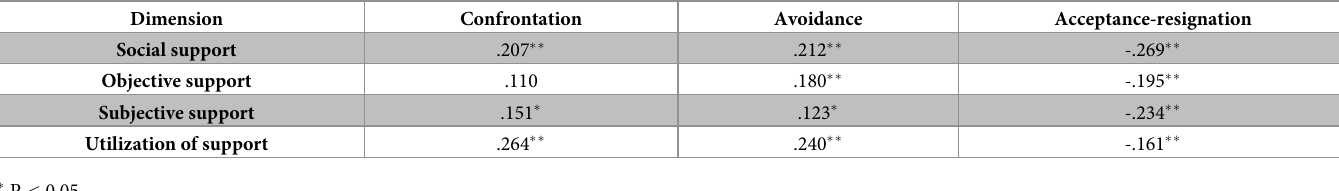
Table 5. Correlation analysis of social support and medical coping modes in female patients treated with IVF-ET (r). Dimension